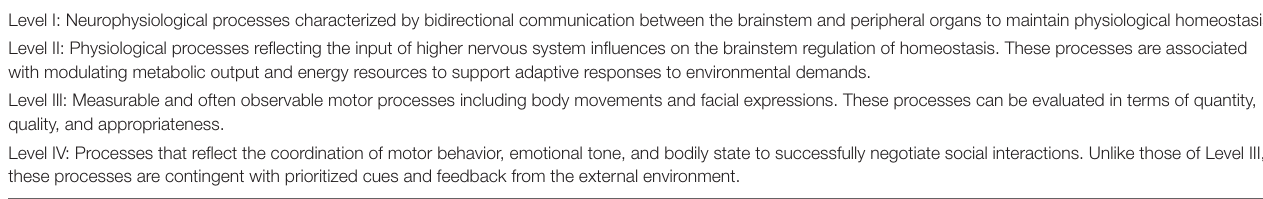
TABLE 1 | Hierarchical model of self-regulation (Porges,